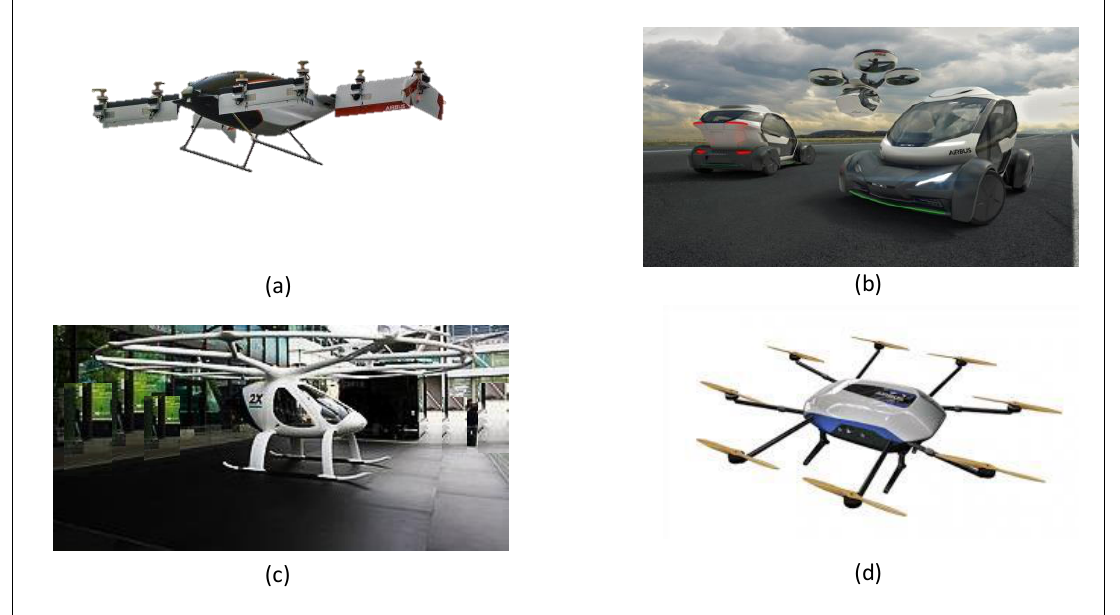
Figure 1. VTOL platform prototypes and concepts for Urban Air Mobility ( a ) Airbus Vahana ( b ) Airbus Pop.up ( c ) Volocopter ( d ) Airbus Skyways.